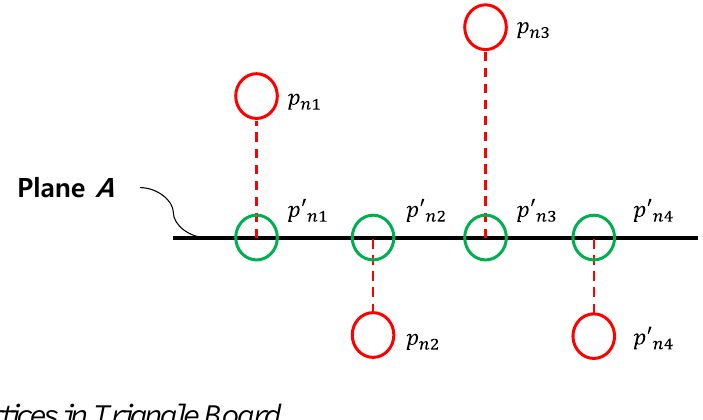
Figure 7. Projection of 3D points (red) onto the estimated plane represented by green circles ʹ.